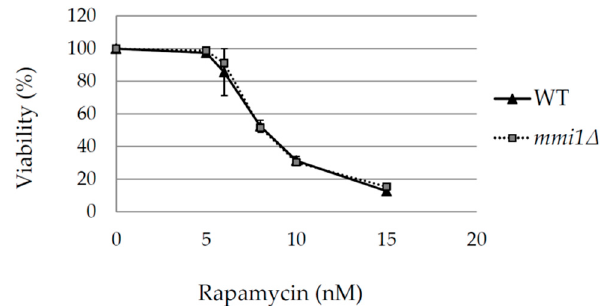
Figure 7. Sensitivity to rapamycin is not influenced in the mmi1 ∆ strain. WT and mmi1 ∆ cells were incubated in the presence of an indicated concentration of rapamycin. Survival curves for the WT and the mmi1 ∆ strains were generated from outgrowth curves and represent the average viabilities of four biological replicates for each strain. Results are means ± SD of two independent experiments performed in duplicates (n = 4).